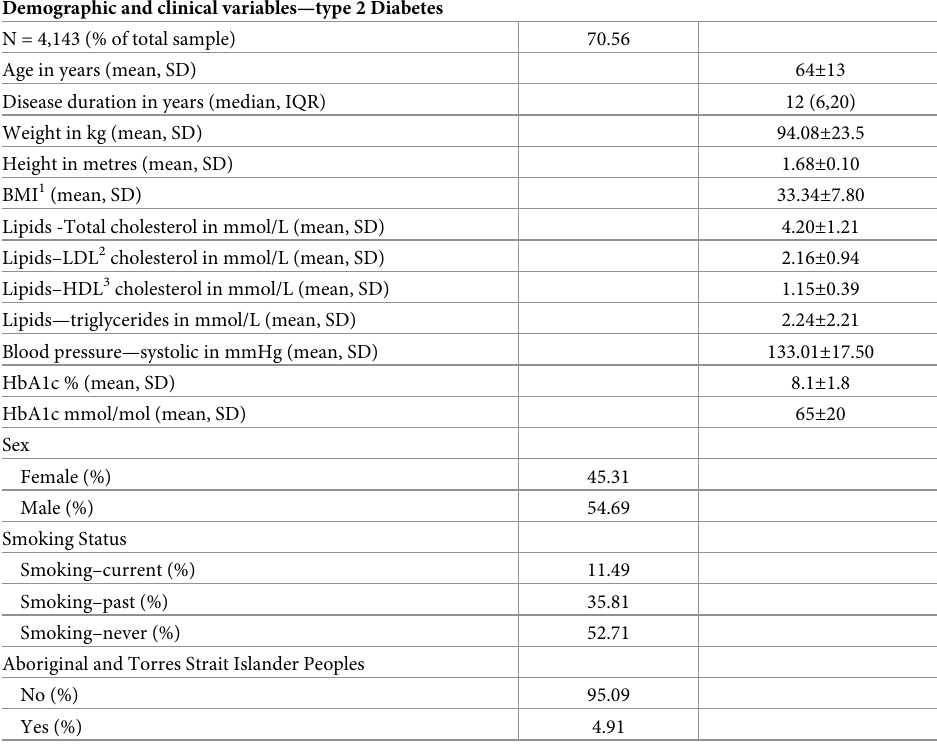
Table 2. Patient demographic and clinical variables–type 2 Diabetes. Characteristics of the sample with type 2 diabetes are shown. 1 BMI: Body Mass Index (calculated in kg/m 2 and categorised according to guidelines from the World Health Organization [25]). 2 LDL: Low-density